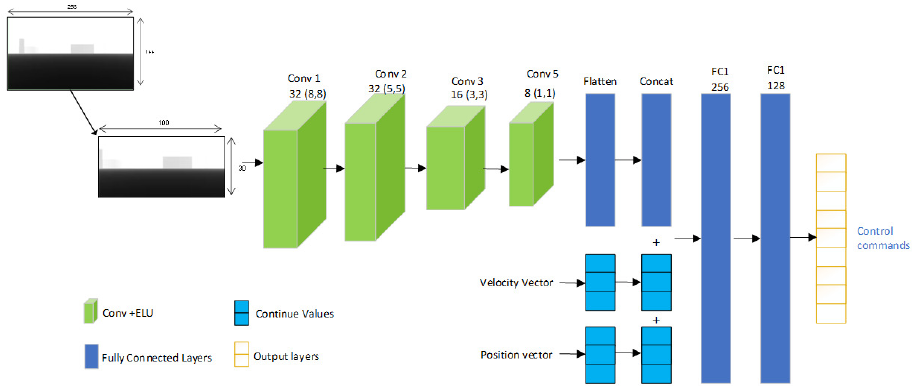
Figure 6. Network architecture for the DQN and DDPG